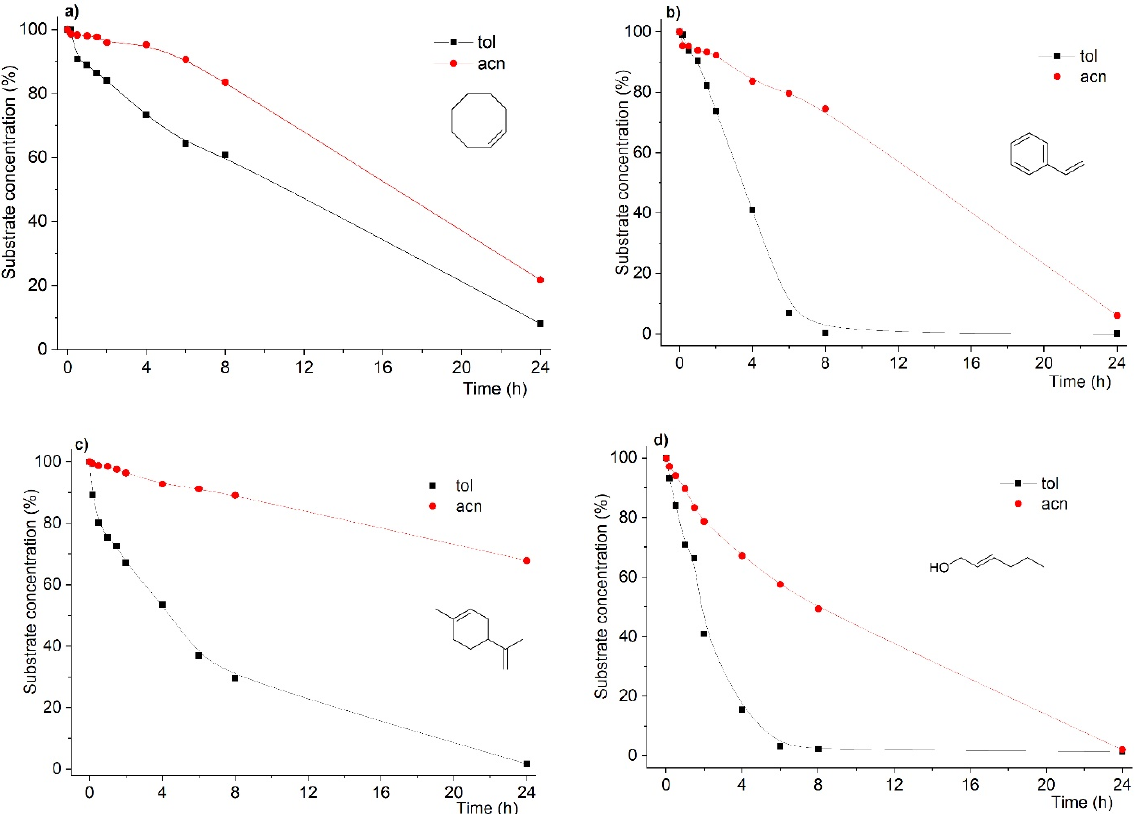
Figure 1. Kinetic profiles of substrate conversion for oxidation reactions of cis -cyclooctene ( a ), styrene ( b ), R -(+)-limonene ( c ) and trans -hex-2-en-1-ol ( d ) in toluene and acetonitrile. Reactions were carried out using substrate:oxidant:catalyst mol % ratio of 100:200:3 using acetonitrile or toluene as solvent and at 353 K.